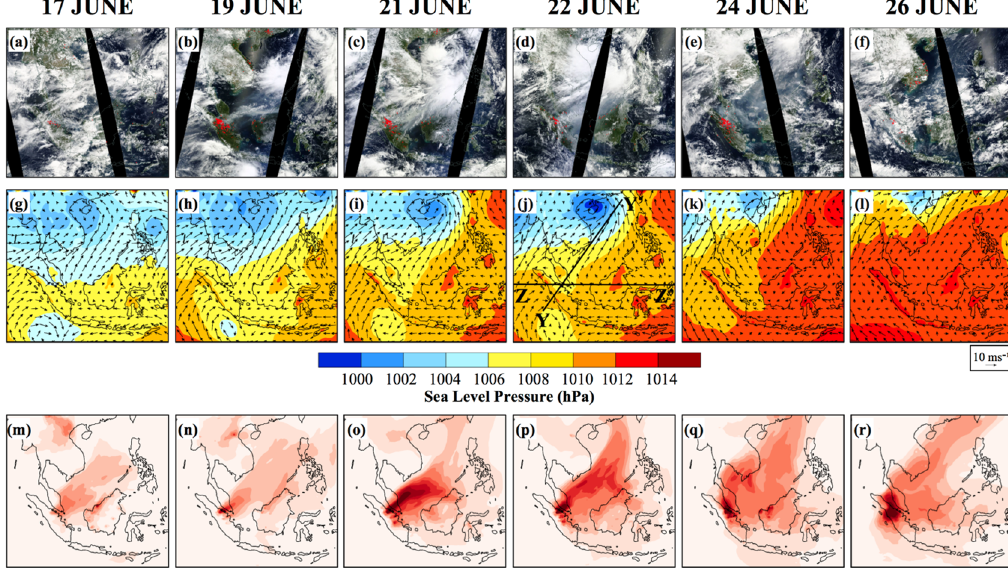
Figure 9. MODIS images from the Terra and Aqua satellites for days between 17 and 26 June 2013 ( a – f ). The red spots correspond to regions of fire hotspots. ( g – l ) The corresponding WRF ‐ Chem simulated daily averaged SLP (hPa) and near ‐ surface wind fields (m s − 1 ). ( m – r ) The daily averaged and vertically integrated PM 2.5 concentration (darker red plumes indicate higher concentrations of PM 2.5 ). The black lines over (j) represent cross ‐ sections YY’ and ZZ’.